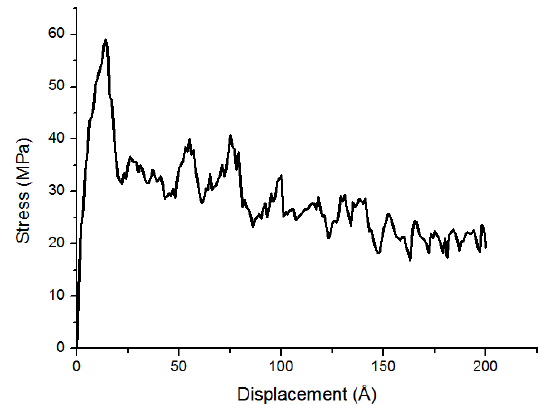
Figure 7. The shear stress-displacement curve of the PE(76 – 40)/S interface.